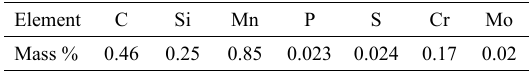
Table 1. Chemical composition of the SAE 1045 steel.